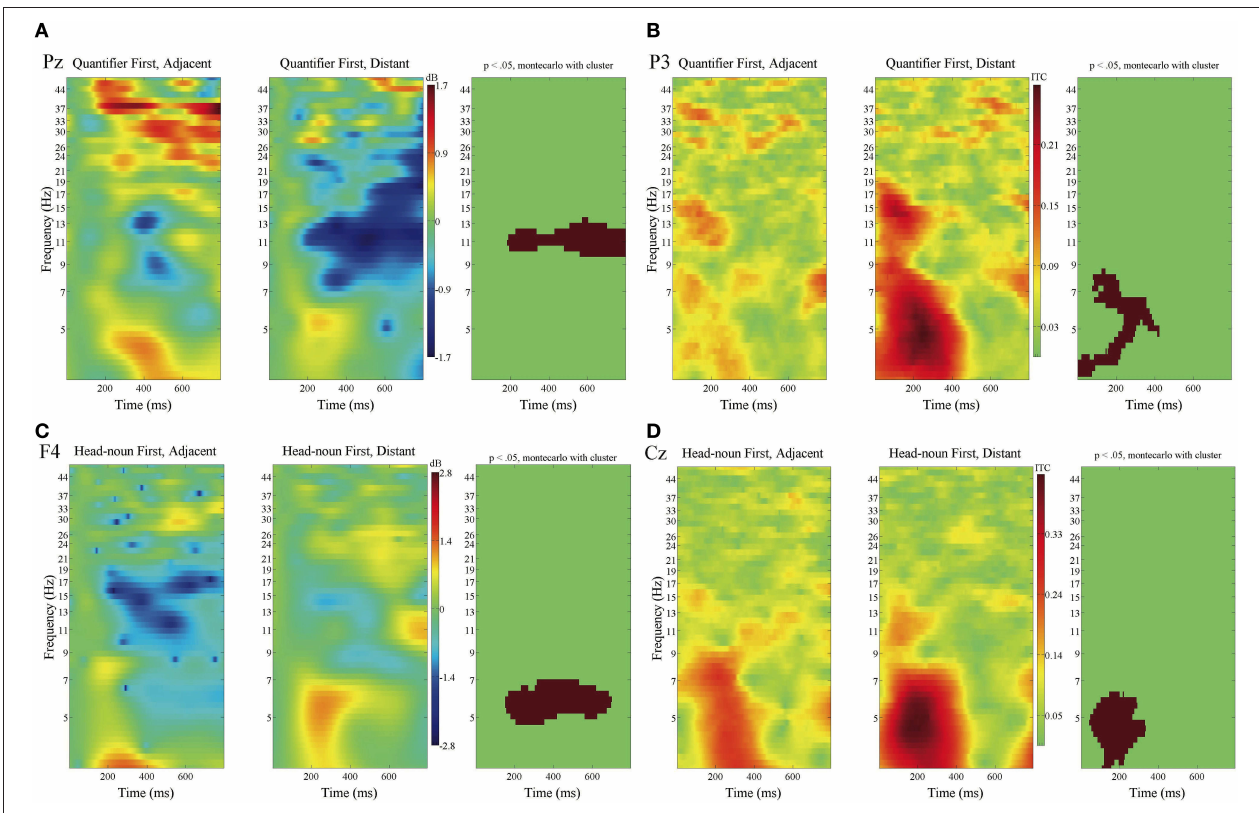
FIGURE 8 | ERSPs and the ITCs time-locked to the onsets of the fifth phrases of Quantifier First and Head-noun First sentences in (A–D) with the baseline from 0 to 100 ms. ERSP at Pz in (A) and ITC at P3 in (B) for Quantifier First, and ERSP at F4 in (C) and ITC at Cz in (D) for Head-noun First. Time windows and frequency bands are depicted in red, where significant differences were found between Adjacent and Distant by using the cluster-based permutation test ( p <